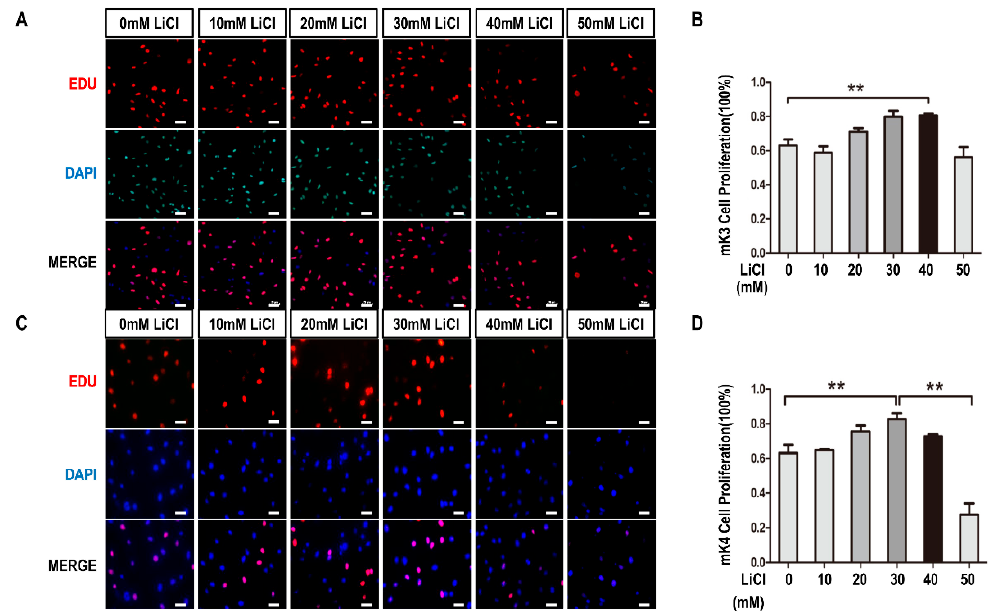
Figure 1. LiCl promotes cell proliferation in mK3 and mK4 cells. ( A ) mK3 cells were treated with LiCl of increasing dosages (0, 10, 20, 30, 40, and 50 mM) for 12 h and performed with 5-ethynyl-20-deoxyuridine (EdU) assays. Proliferating mK3 cells were labeled with EdU (red) and cell nucleuses were stained with DAPI (blue). The EdU results were accessed by fluorescent microscope (200 × ) with the scale bar representing 20 µ m and the respective pictures were merged to the purple one; ( B ) Statistical analysis of mK3 cell proliferation. Values were presented as mean ± SEM ( n = 3). p -values were calculated by Student t -test, ** p < 0.01 relative to control; ( C ) mK4 cells were treated in the same way as in ( A ) and the EdU assay were conducted; ( D ) Statistical analysis of mK4 cell proliferation. Values were presented as mean ± SEM ( n = 3). p -values were calculated by Student t -test, ** p < 0.01 relative to control.